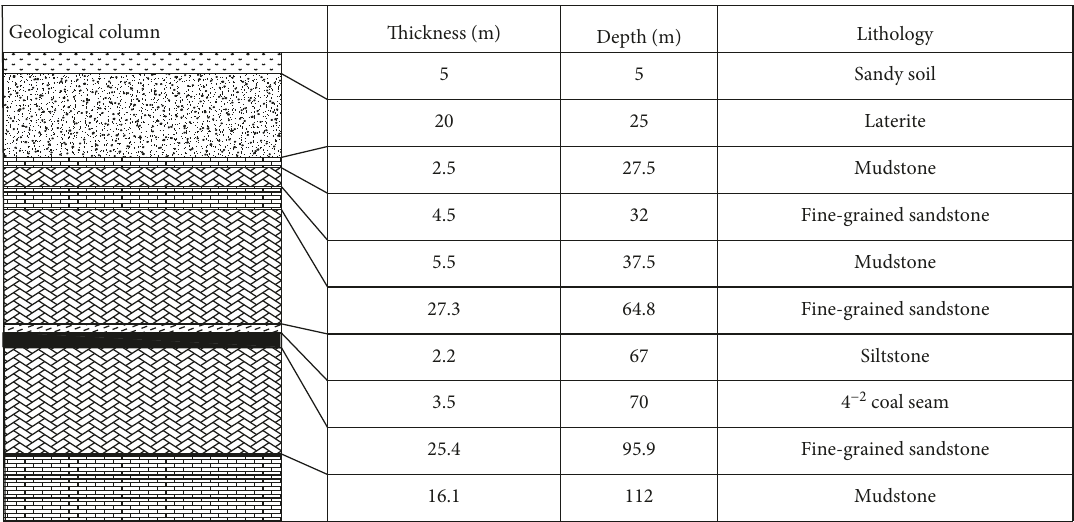
Figure 2: Typical geological log profile of 4 − 2 coal seam overlying strata.